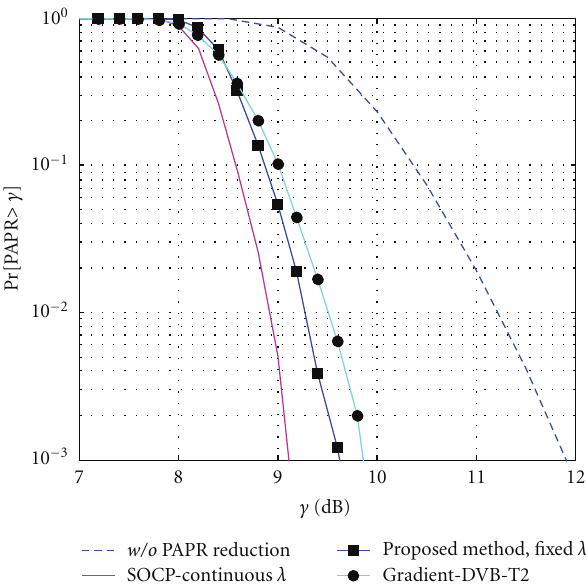
Figure 9: CCDF performance of multiplicative law in discrete domain, 16-QAM, λ = 20dB.